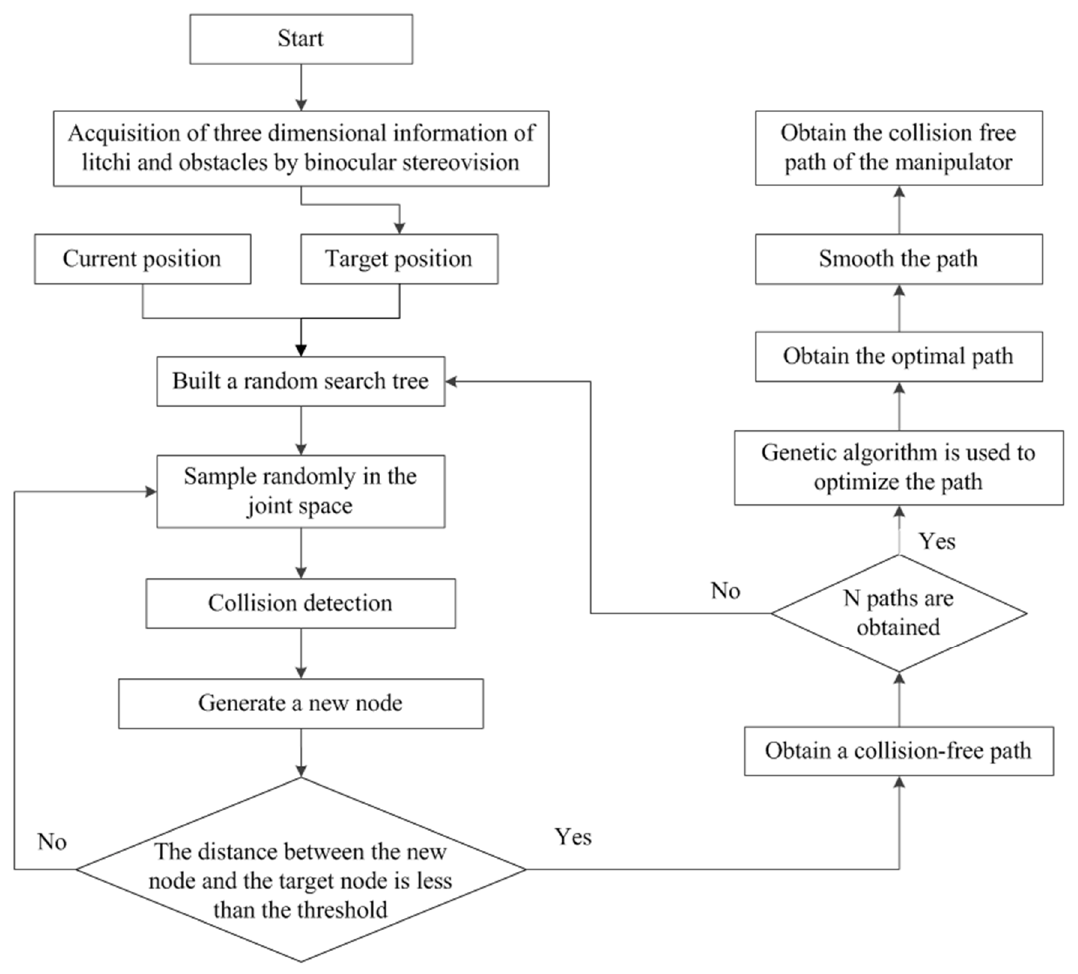
Figure 2. Path planning flow chart.